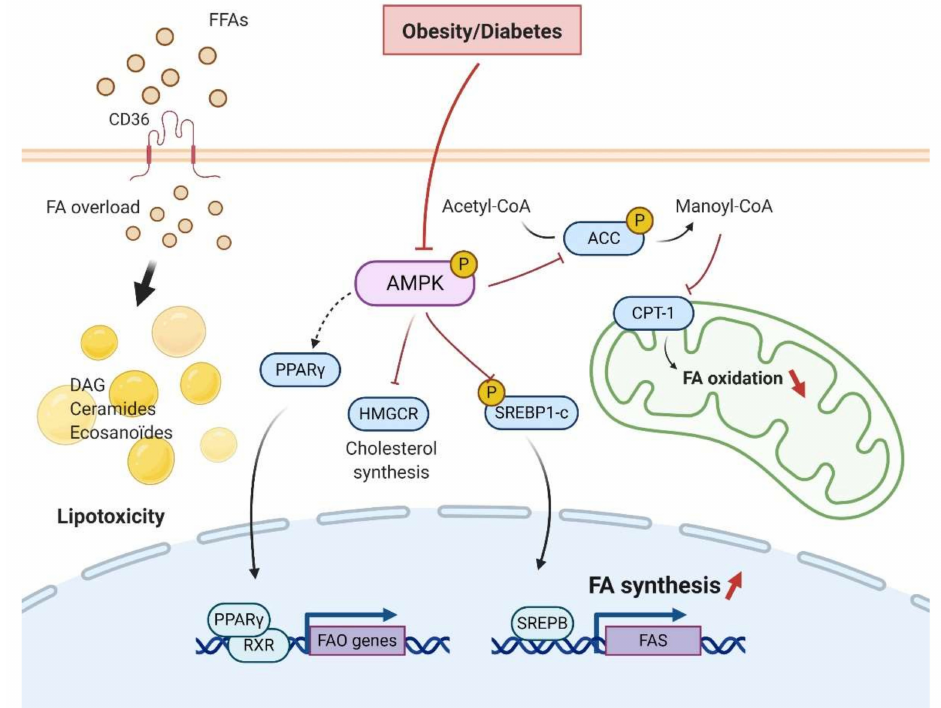
Figure 3. Impaired regulation of lipid metabolism by AMPK in renal cells in obesity / diabetes. Inhibition of AMPK and the increased FA overload lead to a decreased mitochondrial FA oxidation and an enhanced lipogenesis, initiating lipotoxicity in renal cells. Inhibitory phosphorylation of ACC by AMPK is removed, allowing for malonyl-CoA production, leading to inhibition of CPT-1 activity and suppression of FA oxidation in mitochondria. HMGCR and SREBP1-c are enhanced and initiate cholesterol and FA synthesis that contributes to a general increase of lipogenesis, leading to further lipid accumulation in renal cells. Excess FA content associated with impaired AMPK pathway and related lipid metabolism initiates ectopic lipid accumulation in renal cells, including harmful lipid metabolites (DAG, ceramides, and eicosanoids) that cause lipotoxicity. AMPK, AMP-activated protein kinase; ACC, Acetyl-CoA carboxylase; CPT1, Carnitine palmitoyltransferase I; PPAR γ , peroxisome proliferator-activated receptor γ ; HMGCR, 3-hydroxy-3-methyl-glutaryl-coenzyme A reductase; RXR, retinoid X receptor; SREBP, sterol regulatory element-binding proteins; FAS, fatty acid synthesis; FAO, fatty acid oxidation; DAG diacylglycerol; FFAs, free fatty acids. The arrow indicates whether the regulation is activating (black) or inhibitory (red). The dashed arrow indicates a potential